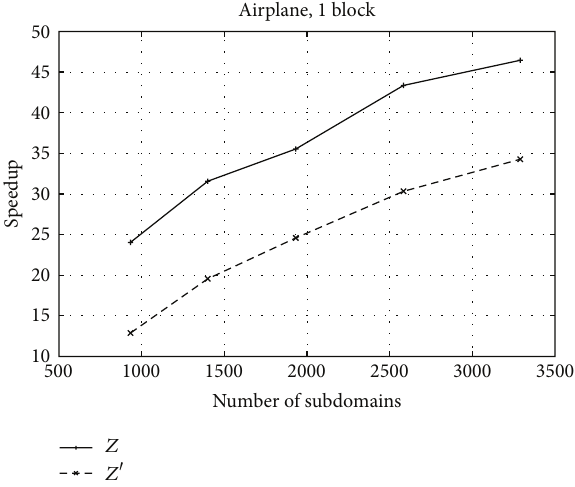
Figure 8: Speedups for calculating the system matrix ( 𝑍 ) and the reduced system matrix ( 𝑍 󸀠 ) for the airplane.